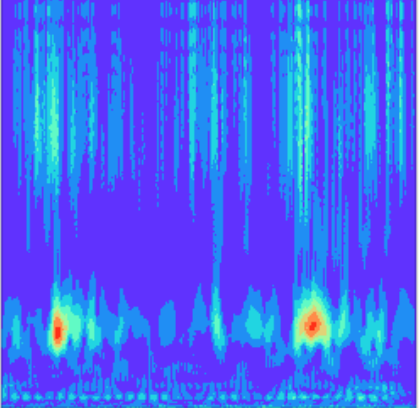
Figure 4. Image of WT-based time–frequency domain input